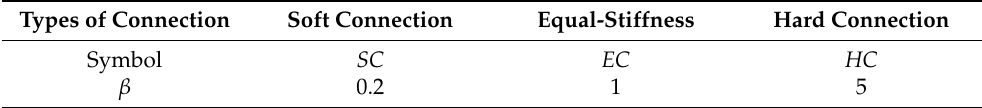
Table 1. Frequency ratio of different types of